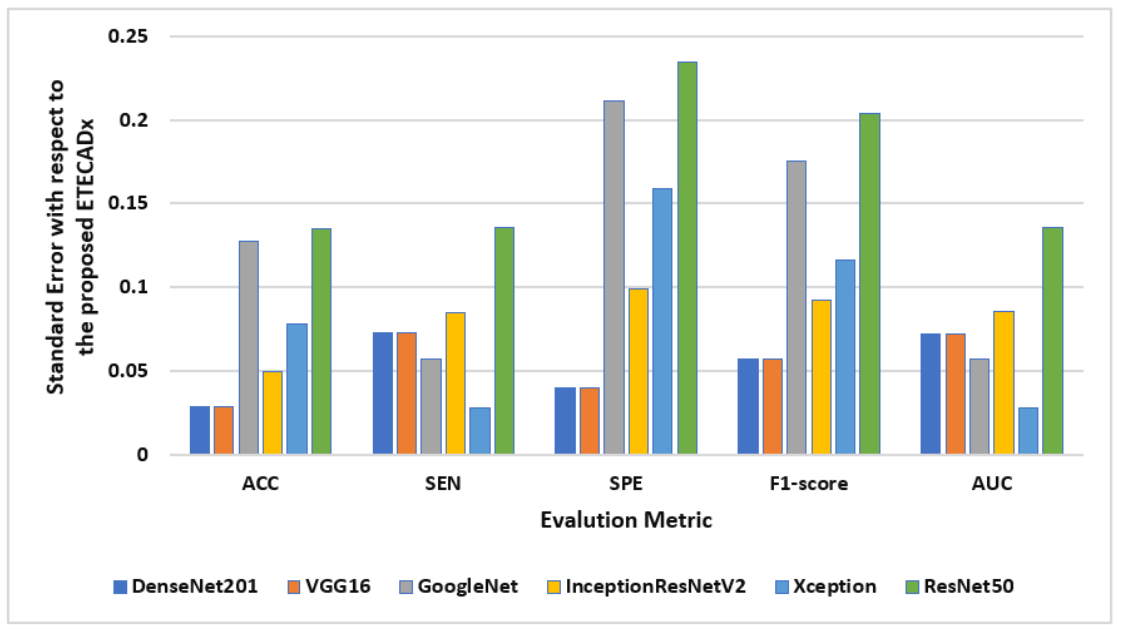
Figure 11. Evaluation error performance of the individual AI models with respect to the proposed ETECADx model for the binary approach.